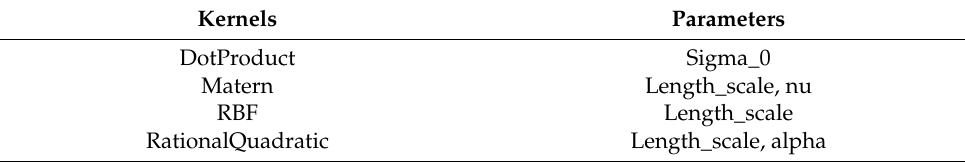
Table 2. The gaussian process kernels’